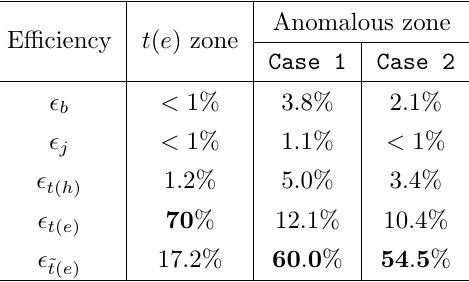
Table 1 . E(cid:14)ciency values for all the jet samples for di(cid:11)erent cuts on the response plane. the fake rate in the t ( e ) zone is less than 1% even for light (cid:13)avor jets without requiring any further b tagging. The anomalous zone in Case 2 also provides another example where even without b tagging the mistag rate from light (cid:13)avored jets can be controlled well below 1%. Even in Case 1 , the anomalous zone has (cid:15) = 1 : 1%, which suggests that this operating j point can be useful as long as the fake rate from b jets at order 4% is